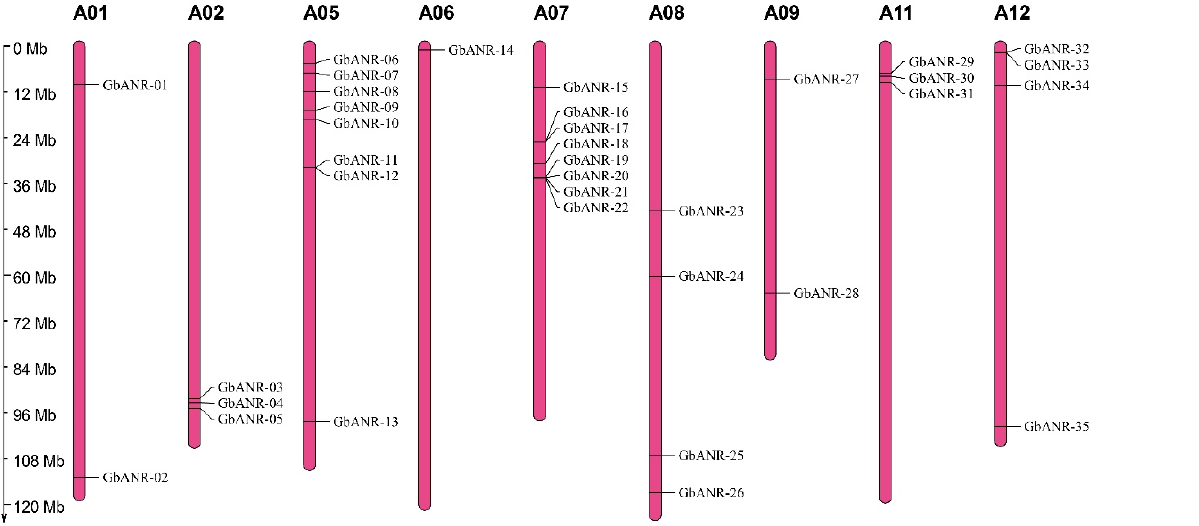
Figure 1. Chromosomal localization of G. barbadense ANR genes. 2.2. Evolutionary Analysis of the ANR Genes in Cotton To further understand the evolutionary relationship of the ANR genes in cotton, a phylogenetic tree including the full length of 69 ANR genes from G. barbadense , six ANR genes from rice, and one ANR gene sequence from Arabidopsis thaliana was constructed (Figure 2a). The tree was divided into five groups according to the results. Only subgroup III contained ANR genes from Arabidopsis thaliana and rice, suggesting that significant tan- dem duplication of the ANR gene family members occurred during the course of evolu- tion, resulting in an increased amount of ANR genes in tetraploid cotton.